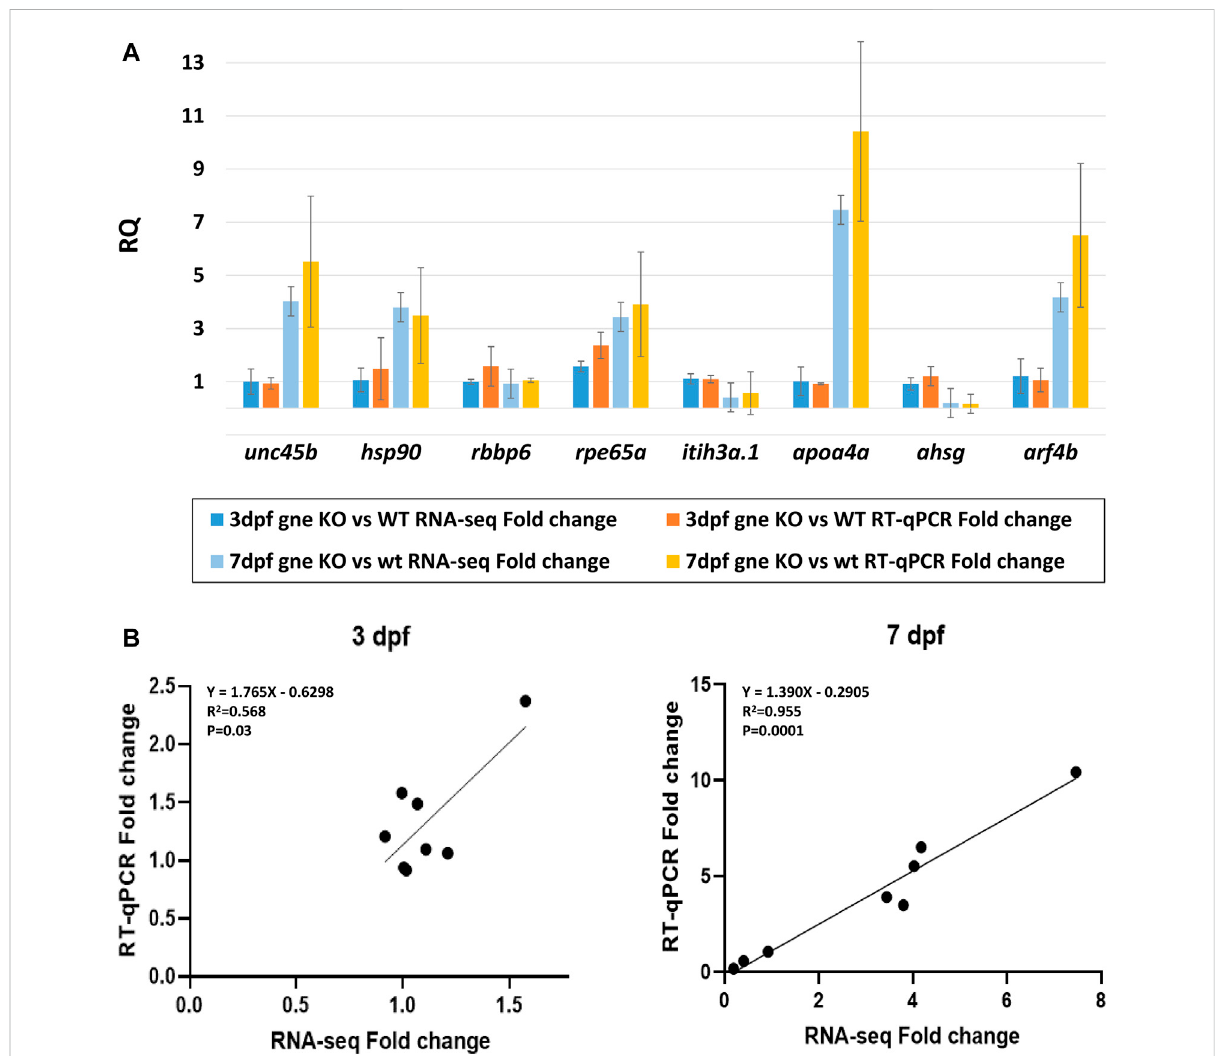
FIGURE 11 Validation of the transcriptomic data. (A) Comparison of the fold-change values between RNA-sequencing and RT-qPCR data for 8 chosen DE genes shows consistency at 3 dpf and 7 dpf samples (20 embryos/sample, 2 biological replicates). Y axis represents the mean RQ values, standard deviations are presented. (B) Gene expression correlation between RT-qPCR and RNA-seq fold-change at 3 dpf and 7 dpf. Linear regression equations, R 2 and p values are presented (Pearson ’ s correlation